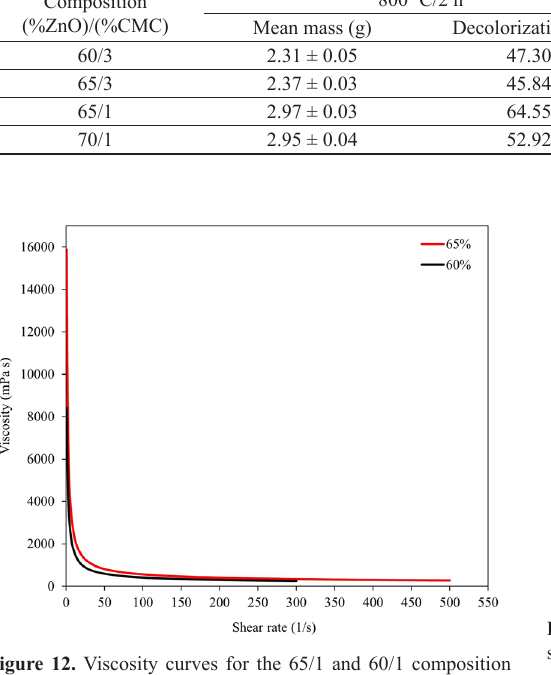
Table 5. Decolorization results obtained after photocatalytic experiments of 60/3, 65/3, 65/1, and 70/1 heat-treated ZnO compositions at 800 ºC/2 h and 1000 ºC/2 h. Composition (%ZnO)/(%CMC)